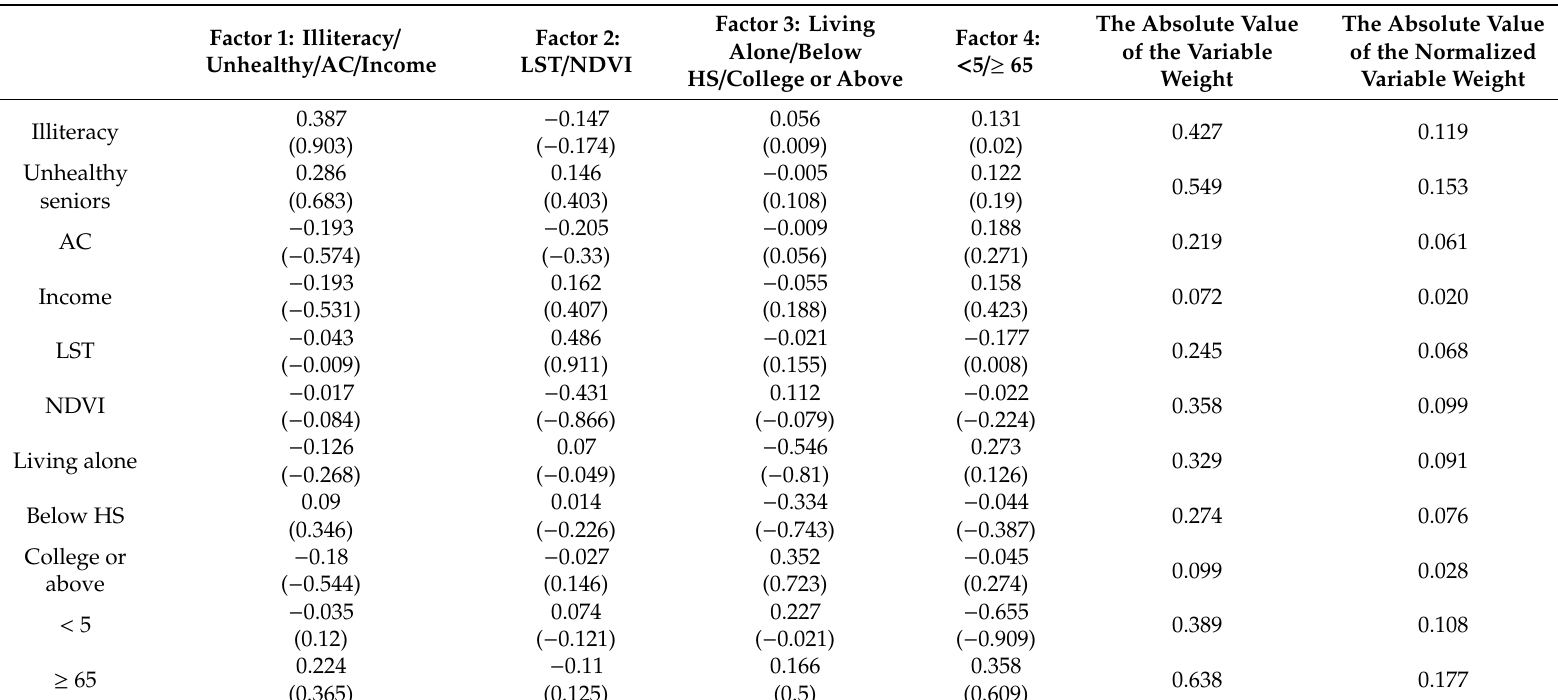
Table 4. Variable weights and factor loadings for heat vulnerability variables for various factors based on data from 130